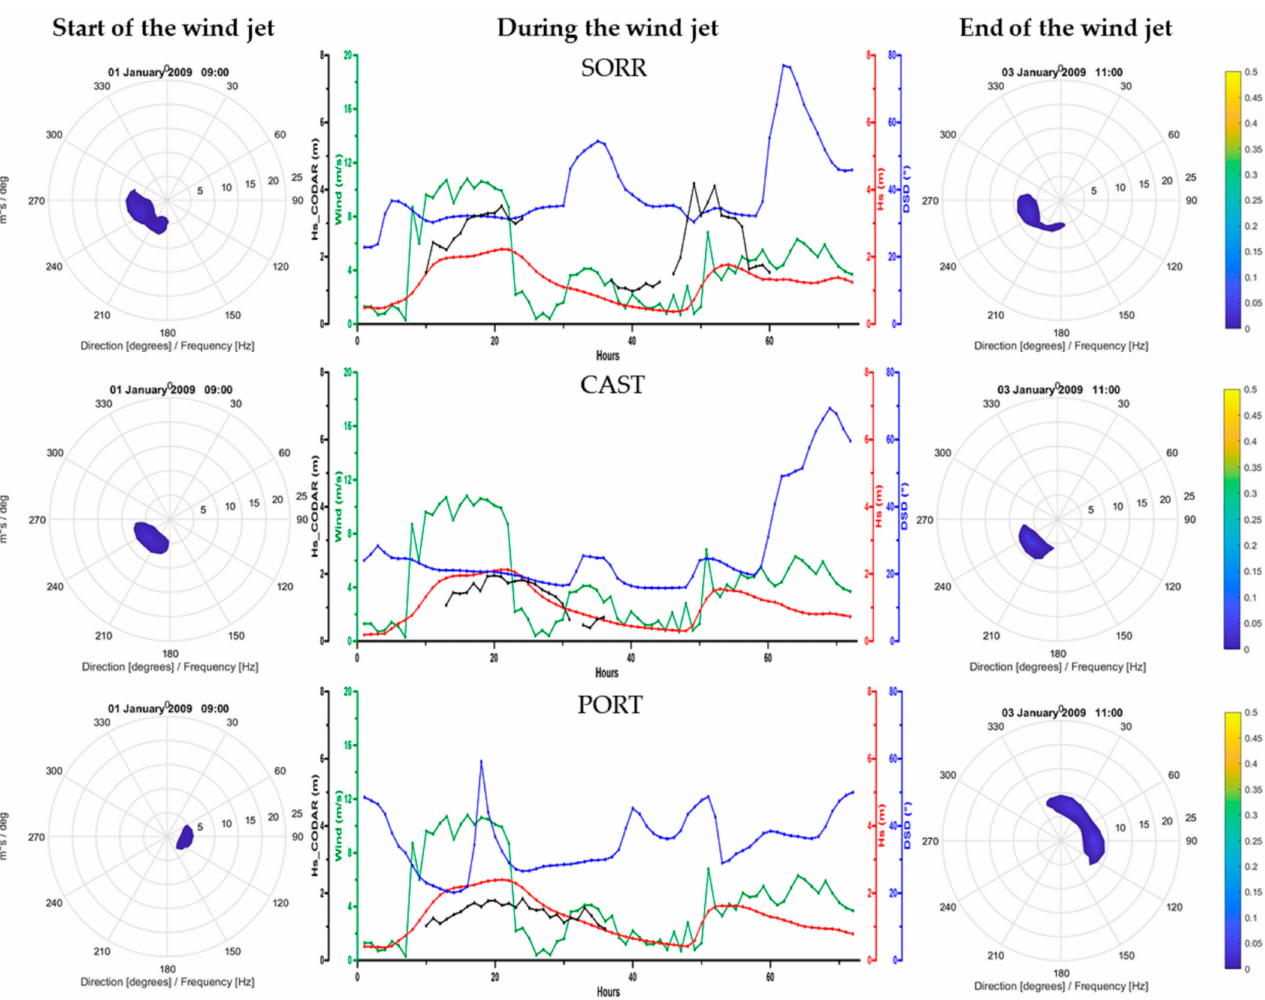
Figure 7. Evolution of storm event (January 2009). First and third panels show the model spectral energy at the wind jet starts and finishes, respectively. The central panels illustrate the evolution, during the event, of the wind intensity (in green), significant wave height (of the model (in red) and retrieved by the HFr Hs HF (in black)) and the directional spreading DSD